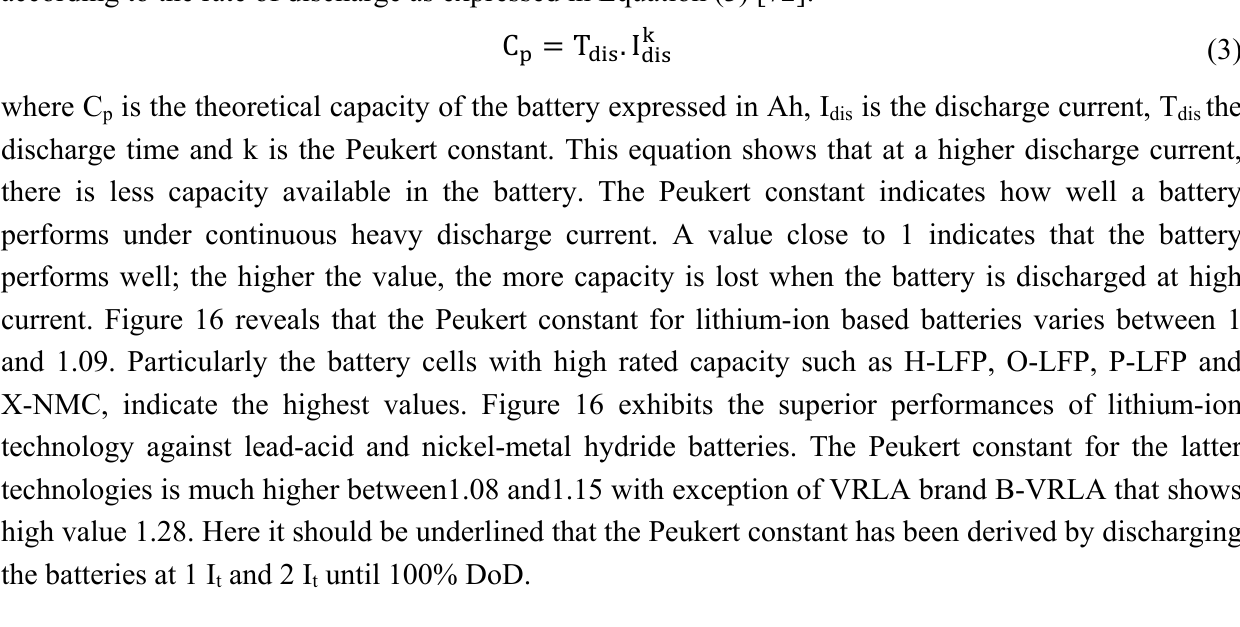
Figure 16. Peukert constant of various lithium-ion battery